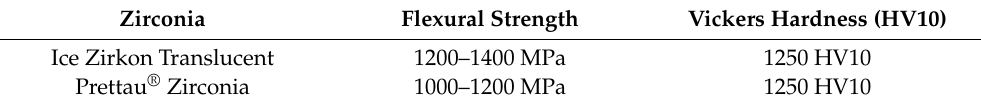
Table 1. Zirconia characteristics. Zirconia Flexural Strength Vickers Hardness (HV10) Ice Zirkon Translucent 1200–1400 MPa 1250 HV10 Prettau ® Zirconia 1000–1200 MPa 1250 HV10 The interfaces used, as well as the screws, were from IPD ® (Matar ó , Barcelona,